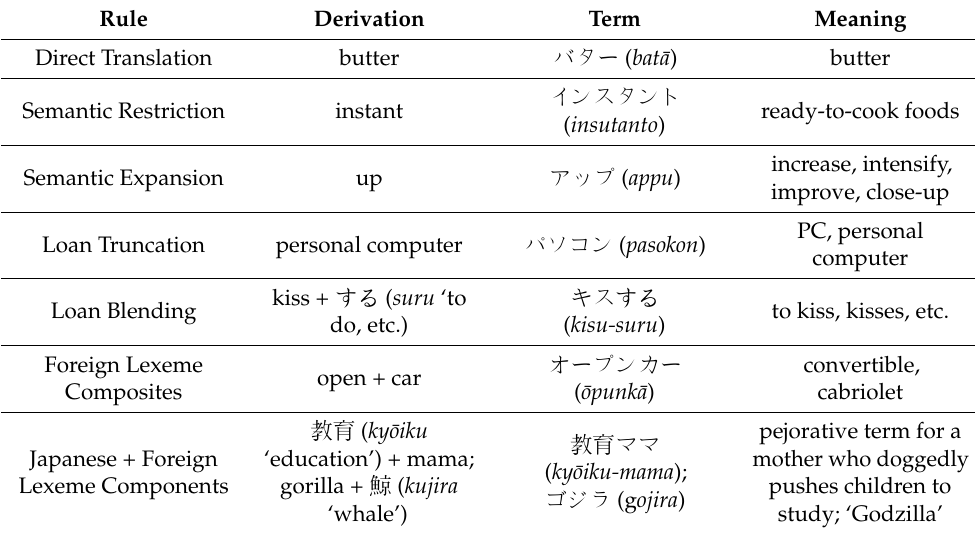
Table 2. Common Paradigms for English-Derived Vocabulary Formation in